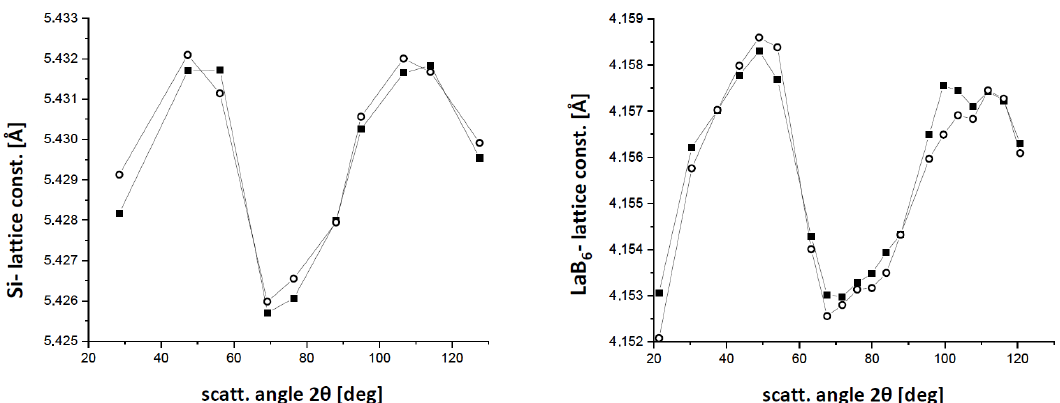
Figure 6. Preliminary results (left: Si, right: LaB 6 )): Measured lattice constants of Si and LaB 6 (powders; both cubic), determined individually from the scattering angle 2 θ of every Bragg peak appearing in the X-ray diffraction (XRD) data. That is, the results shown in the Figures contain no fitting parameter. Results of two independent experiments for each material are shown. The typical error of the determined values of the lattice constant is given by the difference between the two sets of results in each